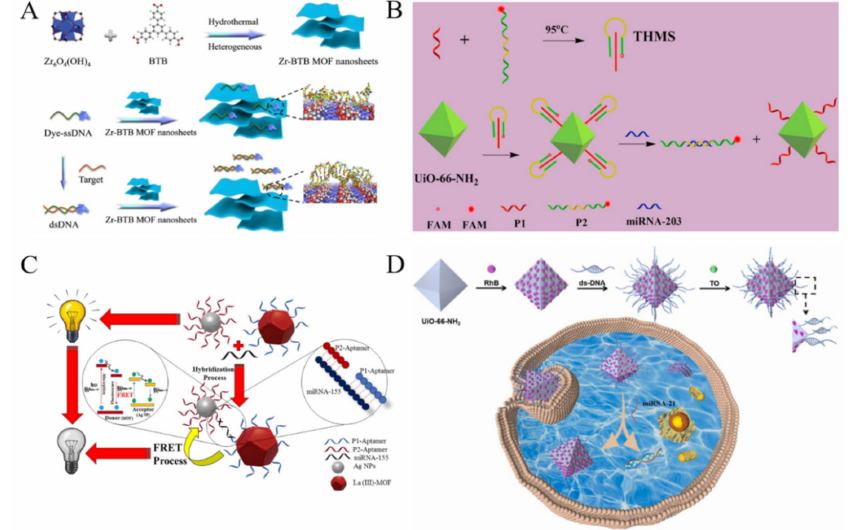
to load the signal strand block Cu-specific DNAzyme precursors and substrate strands (Figure 13B) [185]. The tumor microenvironment promoted the dissolution of DNA@Cu- MOF, leading to the release of extensive Cu 2+ ions, DNAzyme precursors, and substrate strands. The aberrant target miRNA could displace the signal strand by toehold-mediated strand displacement hybridization, thus recovering the fluorescence signal of Cy3-labeled block DNA. More importantly, this reaction would trigger the Cu-specific DNAzyme signal amplification and cause the release of an increasing number of Cy3-labeled DNA stands. Thus, the work proposed a novel method for aberrant miRNA-related hypoxic tumor diagnosis.